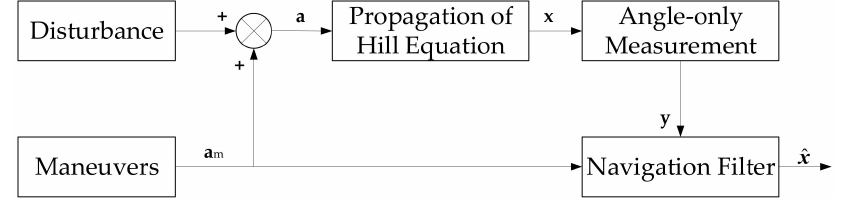
Figure 10. Simulation model of angle-only navigation using resulting approach